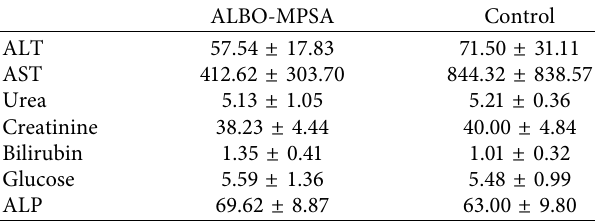
Table 2: Results of analysis of biochemical parameters.